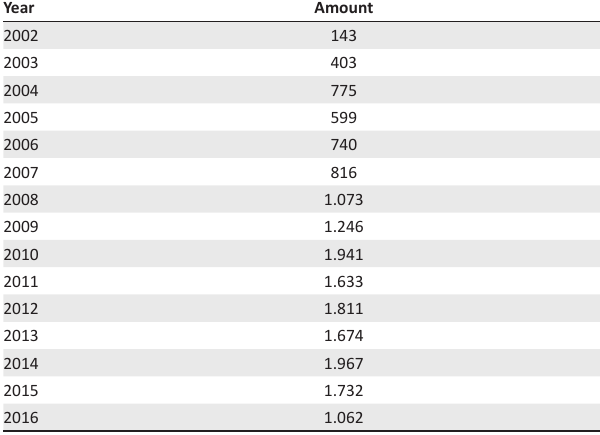
TABLE 1: Average losses due to disasters in Indonesia from 2002 to